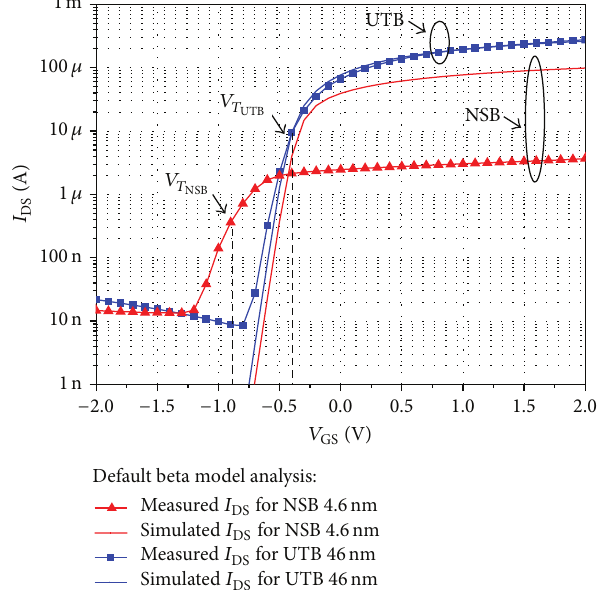
Figure 3: 𝐼 DS - 𝑉 GS transfer characteristics (semilog) measured at = 0.1 VforUTBandNSBdevicehavingachannelthickness (𝑡 𝑉 DS of 46nm and 4.6 nm, respectively, and same 𝑊/𝐿 ratio. The default beta mobility model used in the TCAD device simulator is added as an initial guess